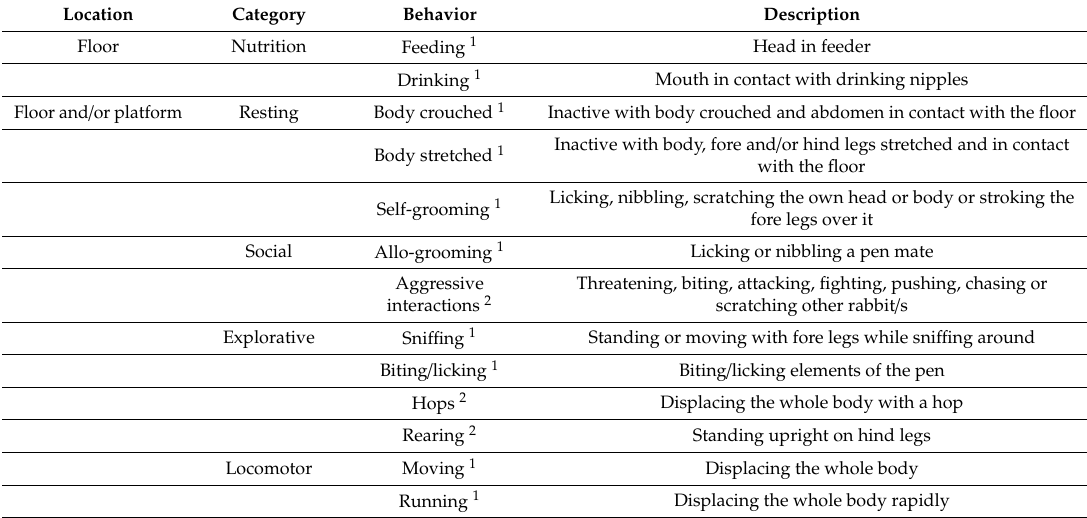
Table 1. Ethogram used for behavioral evaluation of rabbits ( n = 504) with and without environmental enrichment: location, categories and description of behaviors